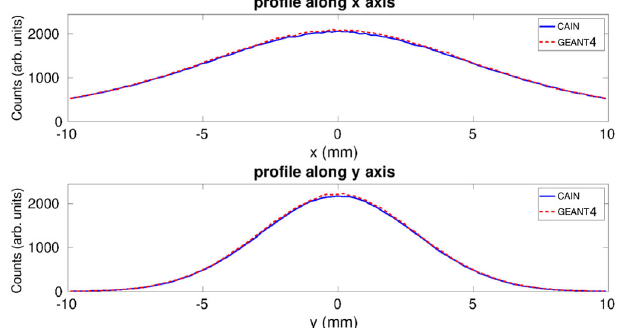
FIG. 9. Profiles of the intensity spatial distribution for the EGammaS-GBS photon beam simulated with CAIN and GEANT 4 . The axis scale is set so as to highlight the most significant part of the distribution.